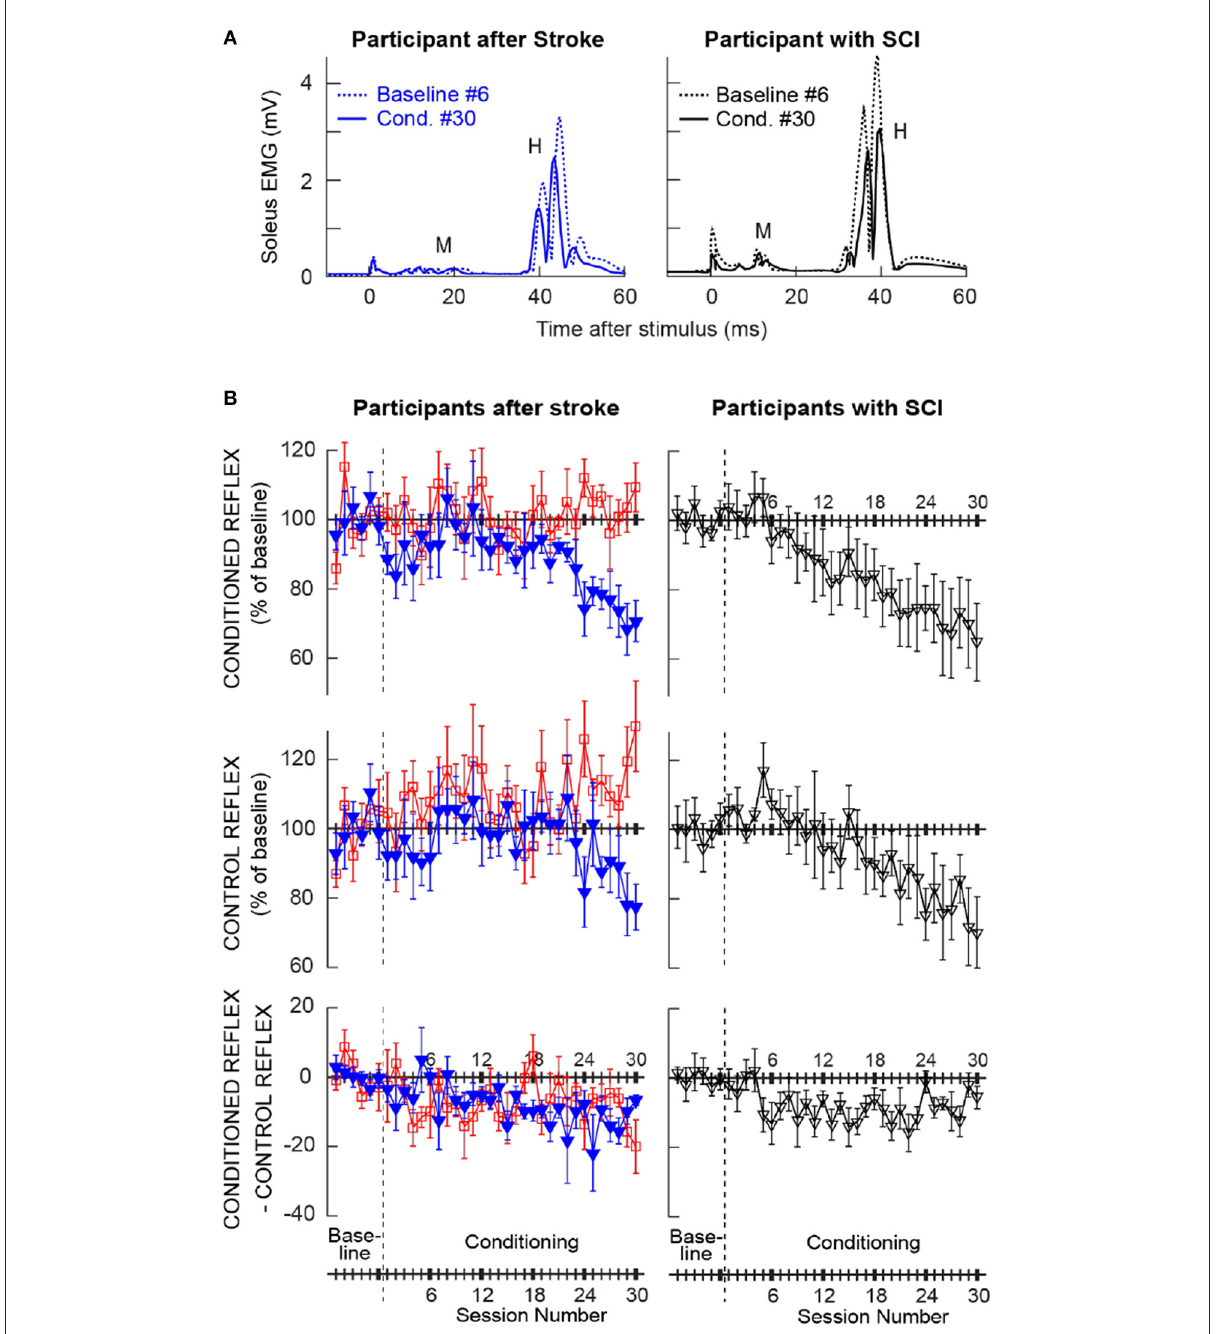
FIGURE2 Changes in the soleus H-reflex brought about by operant down-conditioning. (A) Average conditioned H-reflexes in a baseline session (dashed line) and the last conditioning session (solid line) from a participant after stroke (left) and a participant with chronic incomplete spinal cord injury (right) (25) whose H-reflex decreased significantly. A small stimulus artifact is present at time 0. 225 trials are averaged together for each sweep. (B) Average ( ± SE) H-reflex values for baseline and conditioning sessions for the present groups of participants after stroke (left column) and for the previous group of participants with SCI [right, from (25)]. The present participants after stroke are separated into two groups: the ones whose conditioned H-reflex size decreased significantly (blue, Ss group, N = 6) and the ones whose conditioned H-reflex size did not decrease (red, Sns group, N = 6). Top: Average conditioned H-reflex size. Middle: Average control H-reflex size. Bottom: Average of conditioned H-reflex size minus control H-reflex size [i.e., task-dependent adaptation; for details see